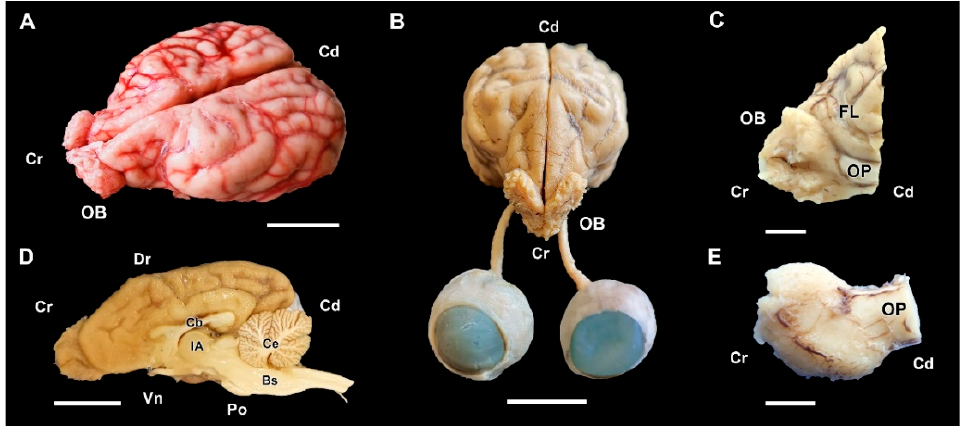
Figure 1. Macroscopic anatomy of the olfactory bulb (OB) of the dog. ( A ) Cranio-dorsolateral view of the encephalon. ( B ) Craniodorsal view showing the OB and its relationship to the optic nerves and eyes. ( C ) Lateral view of the left OB and the frontal lobe of the telencephalon (FL). ( D ) Medial view of the right hemiencephalon showing the rostral projection of the OB. ( E ) Dorsal view of the right OB. Bs, brainstem; Cb, callosal body; Ce, cerebellum; IA, interthalamic adhesion; OP, olfactory peduncle; Po, pons. Position terms: Cr, cranial; Cd, caudal; Dr, dorsal; Vn, ventral. ( A ): Unfixed